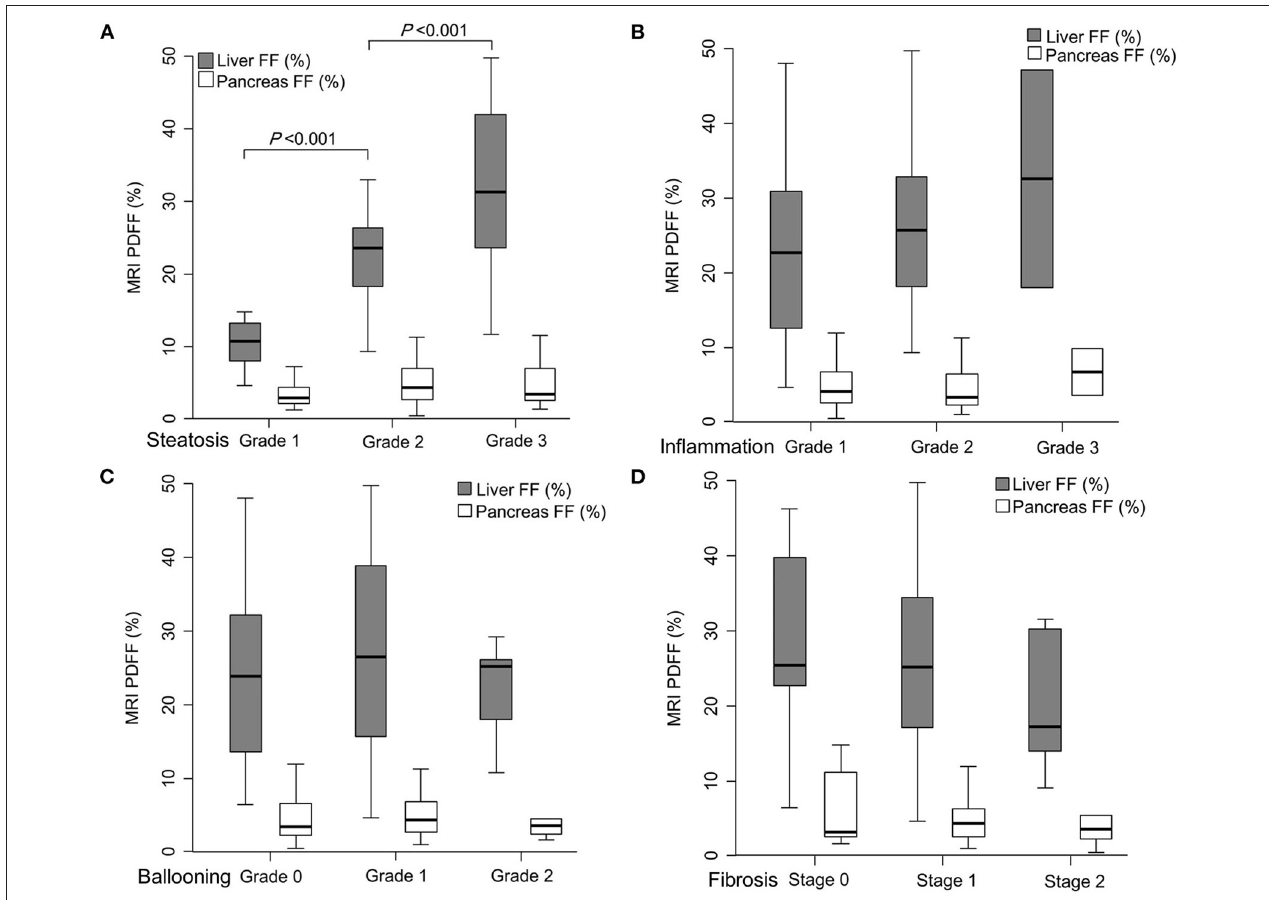
FIGURE 2 | Comparison of magnetic resonance imaging (MRI) proton density fat fraction (PDFF)-measured hepatic fat fraction (HFF) and pancreatic fat fraction (PFF) according to each histological feature of non-alcoholic fatty liver disease (NAFLD); steatosis grade (A) , lobular inflammation grade (B) , ballooning degeneration grade (C) , and hepatic fibrosis stage (D) . HFF significantly increased with the rise of hepatic steatosis grade (10.4, 23.7, and 31.1% in each steatosis grade, P < 0.001). However, HFF was not significantly different when observing other histological features of NAFLD, such as lobular inflammation, ballooning degeneration, and hepatic fibrosis. PFF was not related to any liver histologic features of